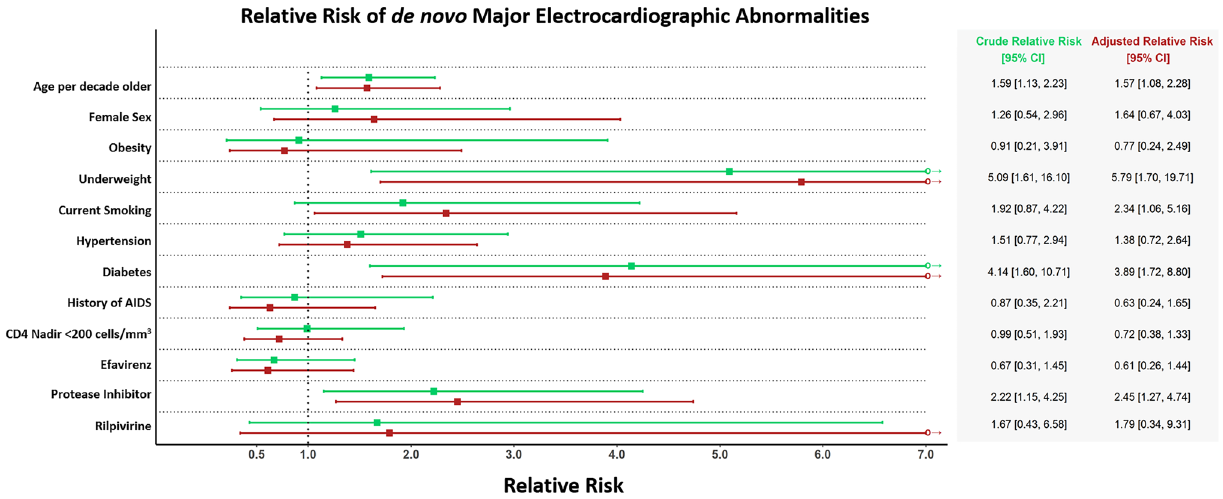
Figure 2. Relative Risk of de novo Major Electrocardiographic Abnormalities. Relative risk (RR) of de novo major Electrocardiographic abnormalities for different predictors with 95% confidence intervals. Vertical dotted line represents an RR of 1. Green is crude (unadjusted) and red is adjusted for age, sex, smoking status, hypertension, BMI, and diabetes. Age age at baseline, obesity body mass index (BMI) ≥ 30 kg/m 2 , underweight BMI < 18.5 kg/m 2 .